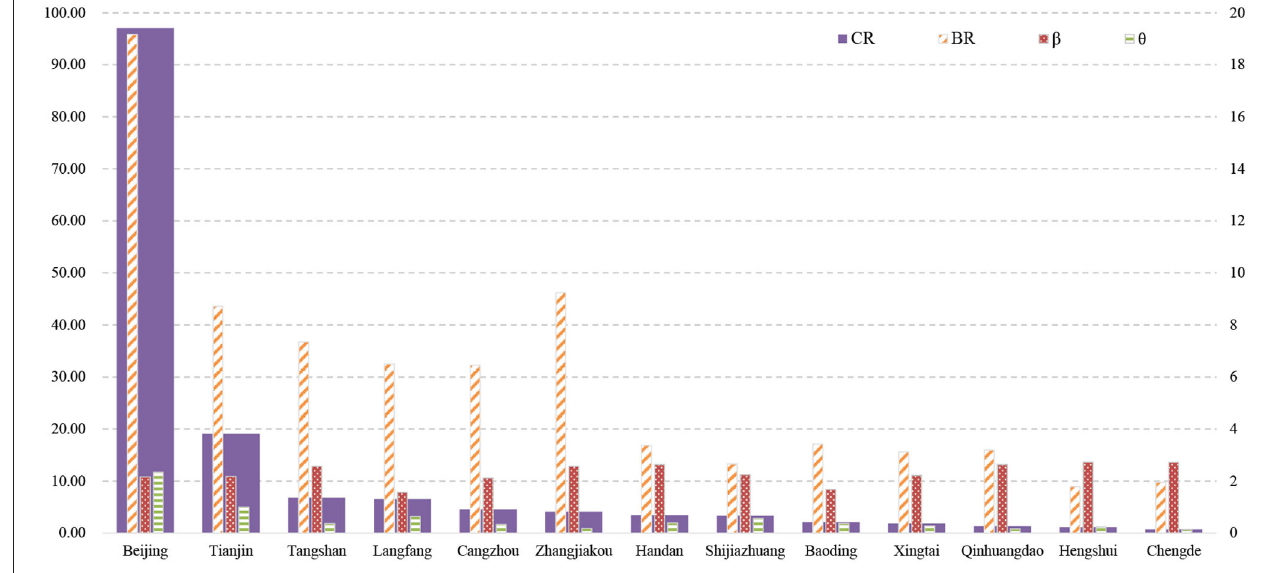
FIGURE 10 | Comprehensive risk of the epidemic in the BTH area.